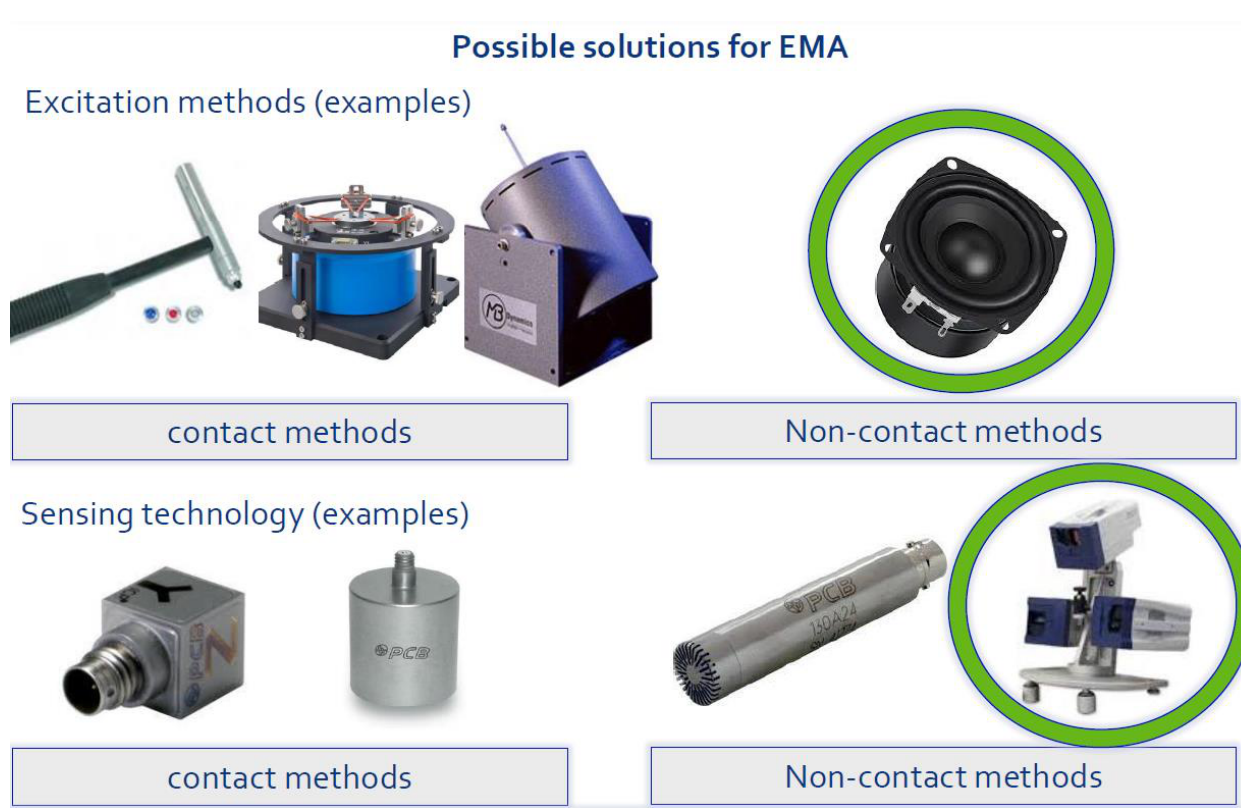
Figure 2. EMA possible solutions for sensing techniques and excitation sources.